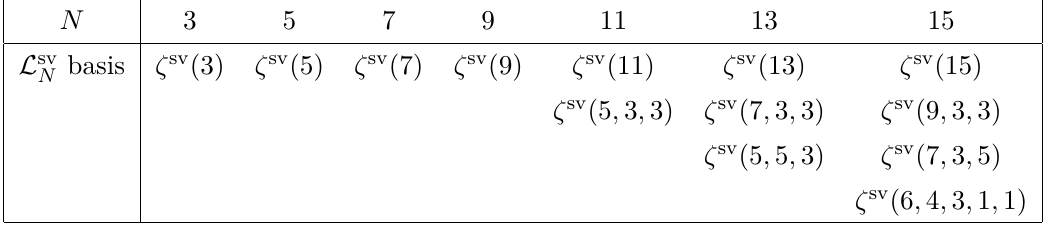
Table 3 . Possible basis for L sv .